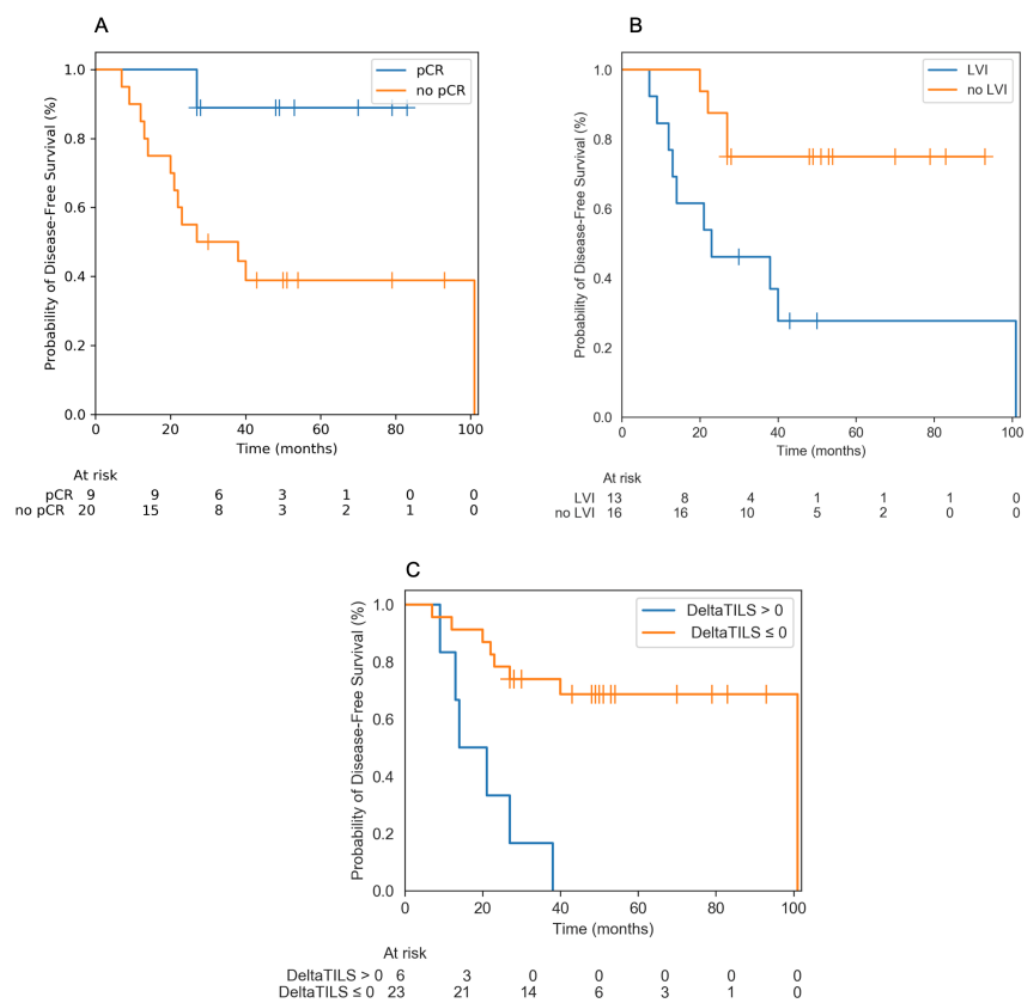
Table 2. Univariate and multivariate analysis of EFS in the whole population.